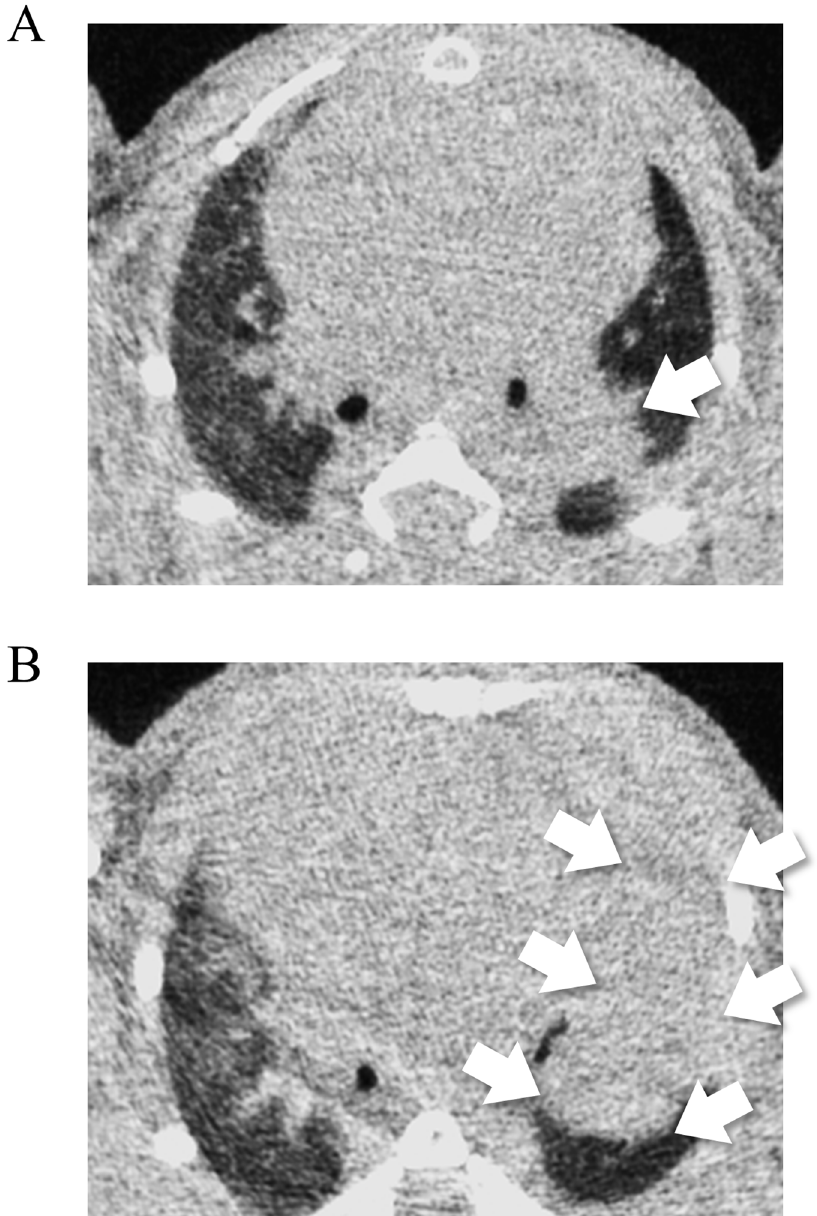
Fig 4. Tumor monitored by animal CT. (A) The CT image 63 days after tumor cell implantation. The longest diameter of the tumor lesion was 8.3 mm in the left lung. (B) The CT image 56 days after tumor cell implantation. The left lung showed more than half